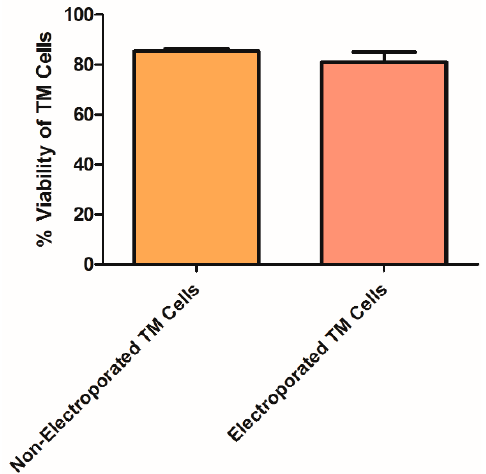
Figure 4. Trypan Blue analysis for the determination of TM cell viability after electroporation. TM cells staining with Trypan Blue dye for the detection of live cells among total cells. Two treatments were examined: Non-electroporated TM cells and electroporated TM cells to estimate the contribution of the electric pulse to cell death. Data represent means ± SD from three independent experiments performed in triplicates. Student’s t -Test was used to determine statistical difference.